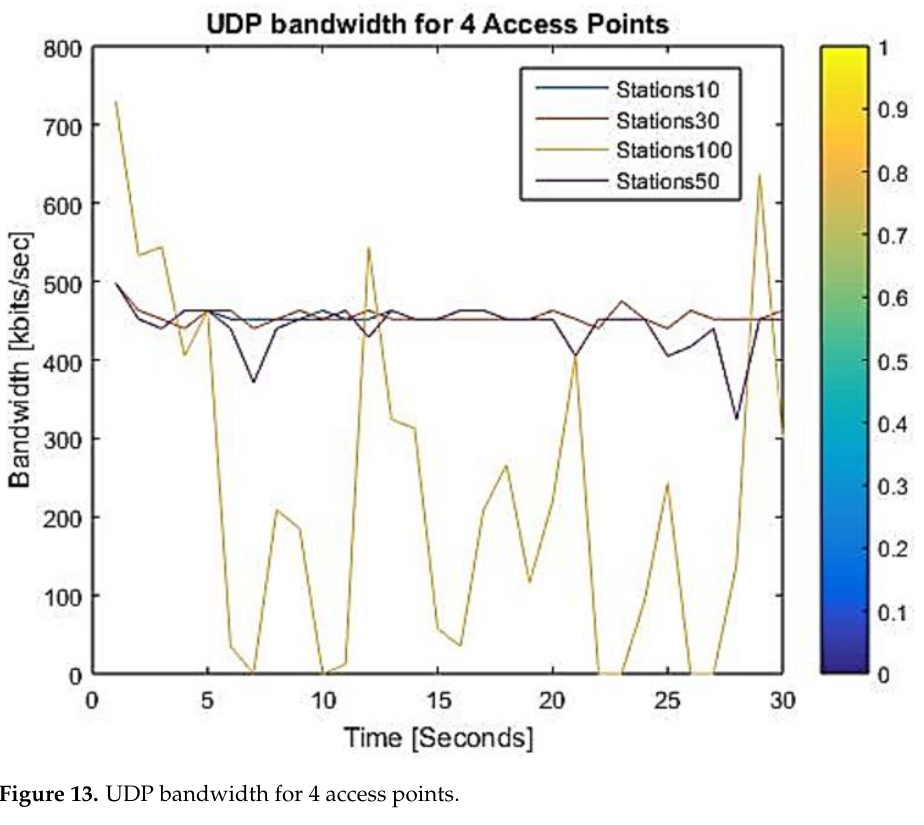
Figure 13. UDP bandwidth for 4 access points.